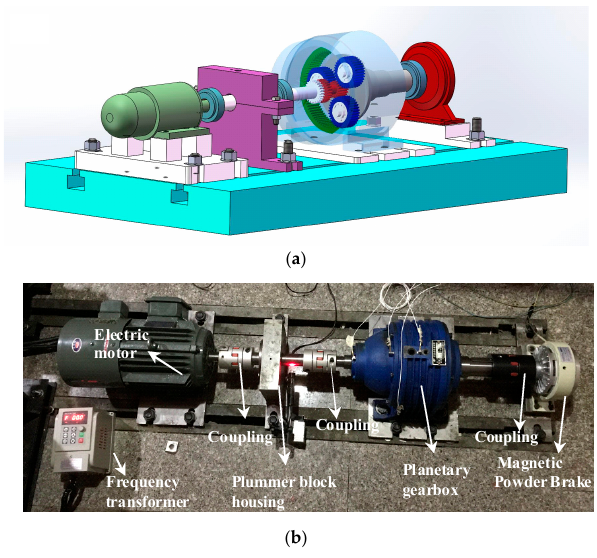
Figure 17. A bearing test-to-failure experiment system. ( a ) System structure; ( b ) Test system.